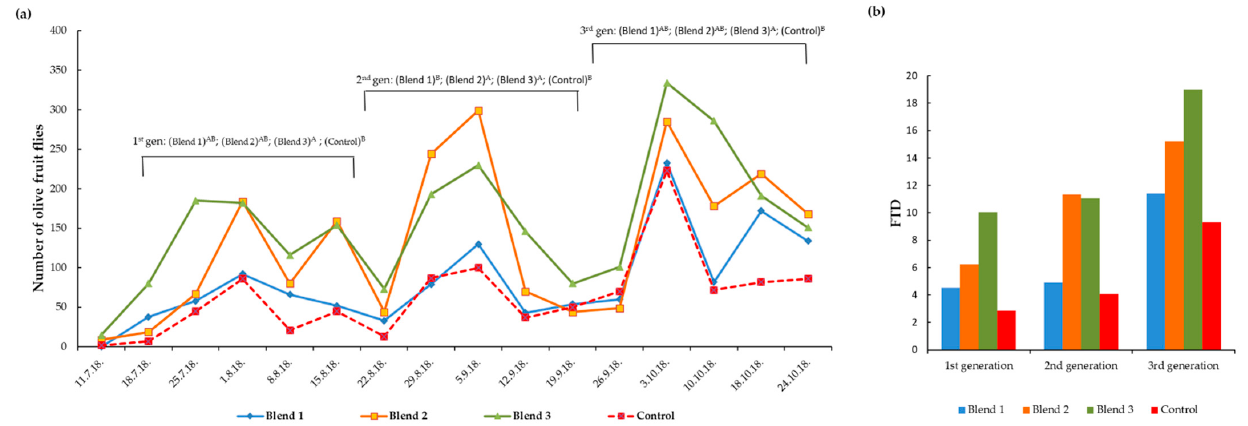
Figure 2. ( a ) Bactrocera oleae population dynamics for three tested blends of olive fruit fly (OFF)- associated yeast volatile compounds and control, in olive orchard during investigation. Blends of OFF-associated yeast volatile compounds were attached on yellow sticky (YS) traps as follows: (Blend 1) 1:1 isoamyl alcohol and 2-phenethyl alcohol; (Blend 2) 1:1:1 isoamyl alcohol, 2-phenethyl alcohol and 2-phenethyl acetate; (Blend 3) 1:1:1 isoamyl alcohol, 2-phenethyl acetate and isobutyl acetate; and (Control) control traps containing only hexane. Different uppercase letters indicate significant differences (LSD test at p ≤ 0.05) between tested traps separately for adult flight of each Bactrocera oleae generation (adult flight of 1st gen—first; 2nd gen—second; 3rd gen—third generation); ( b ) FTD (flies per trap per day) change between adult flights of three generations of Bactrocera oleae (1st–3rd) in relation to YS traps containing different blends of OFF-associated yeast volatile compounds and control, in olive orchard during investigation. Blends of OFF-associated yeast volatile compounds were hung up on yellow sticky traps as follows: (Blend 1) 1:1 isoamyl alcohol and 2-phenethyl alcohol; (Blend 2) 1:1:1 isoamyl alcohol, 2-phenethyl alcohol and 2-phenethyl acetate; (Blend 3) 1:1:1 isoamyl alcohol, 2-phenethyl acetate and isobutyl acetate; and (Control) control